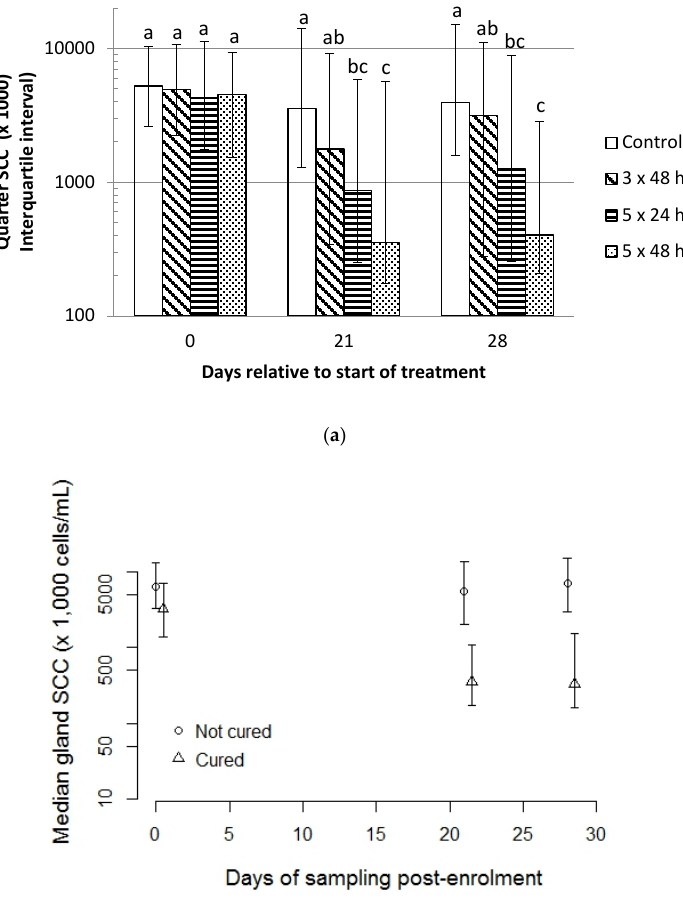
Figure 2. Median (interquartile range) of somatic cell count (SCC; ×1000 cells/mL) by ( a ) day post- treatment and by treatment group irrespective of bacteriological cure outcome, and ( b ) in glands that did or did not undergo bacteriological cure. Columns within days with superscripts differing differ at p < 0.05. The incidence of clinical mastitis within 28 days of enrolment did not differ between treatment groups (0/81 (0%), 9/298 (3.0%), 9/292 (3.1%), and 1/77 (1.3%) for quarters with subclinical mastitis following no treatment (Control), 3 × 48 h, 5 × 24 h and 5 × 48 h interval cloxacillin treatments, respectively; p = 0.36).